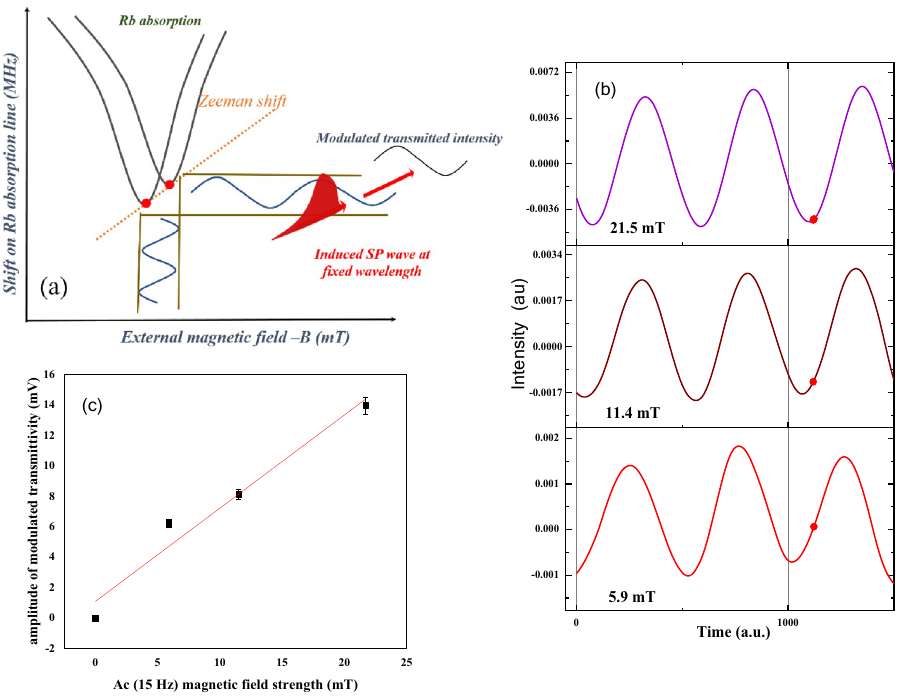
Figure 5. ( a ) Schematic diagram of transmitted light modulation from SP- atom coupled system, as applied modulated B field alters absorption line of atom over Zeeman shift. ( b ) Transmittivity of Rb atom -SP system at three different strength of applied ac magnetic field. Red colored point shows the phase change of modulated transmittivity at different strengths of applied field, B. ( c ) Amplitude of modulated transmittivity versus strength of magnetic field. In the domain of small changes of magnetic field strength, the sensitivity of transmittivity to ac B field strength is